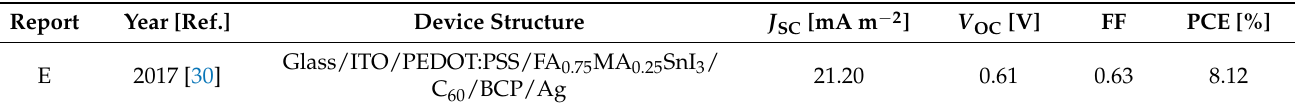
Table 2. Record table containing the reported Sn-PSCs and the corresponding photovoltaic parameters mentioned in Section 2.2. Report Year